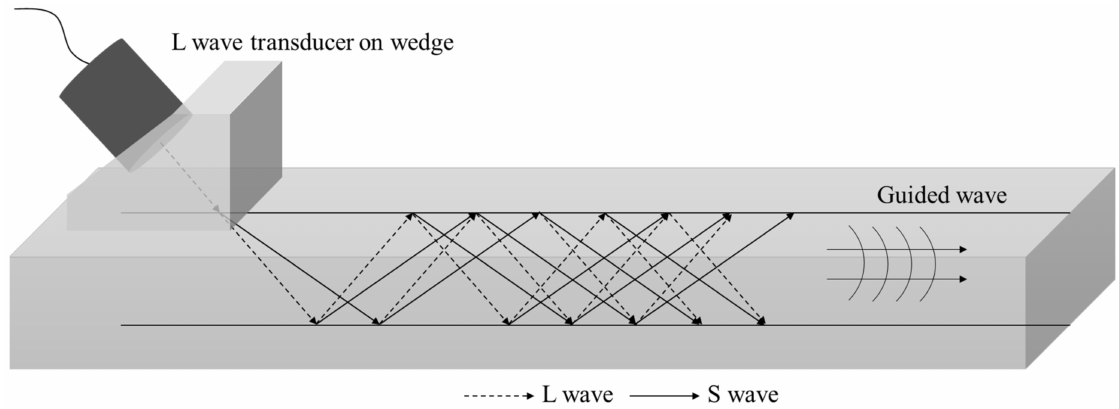
Figure 1. Ultrasonic transducer with wedge to generate ultrasonic GW